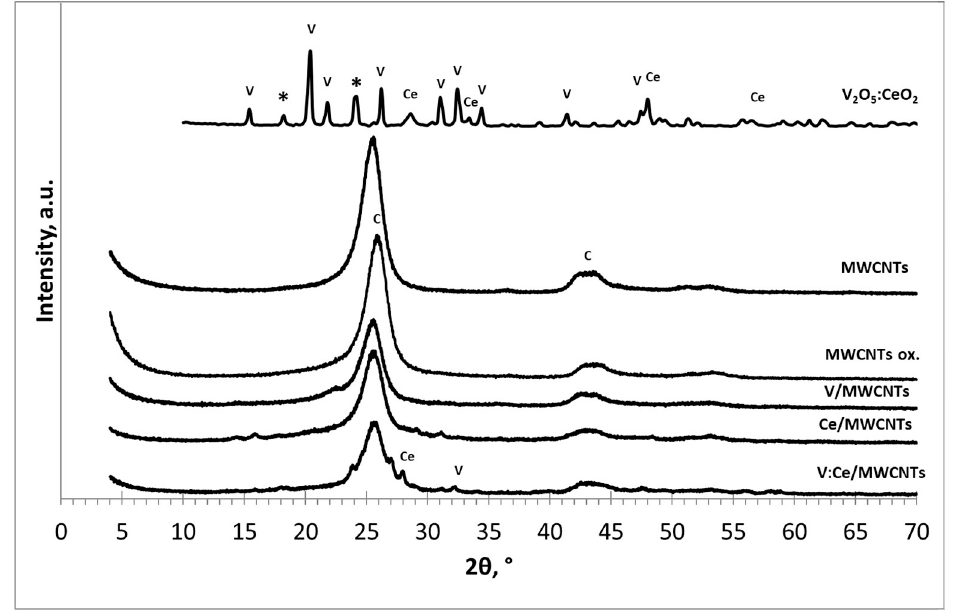
Figure 1. XRD results for fresh and modified MWCNTs, where V, Ce, and C denote the V 2 O 5 , CeO 2 and graphite crystalline phases and * represents impurities.